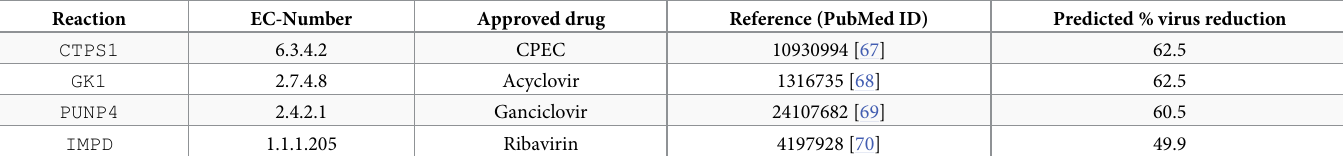
Table 3. Exemplary selection of already approved drugs and compounds that act against proteins associated with our predicted anti-SARS-CoV-2 target reactions and could possibly used for antiviral therapies. All listed drugs have known pharmacological action and are sorted based on the predicted percentage of virus reduction in the wildtype